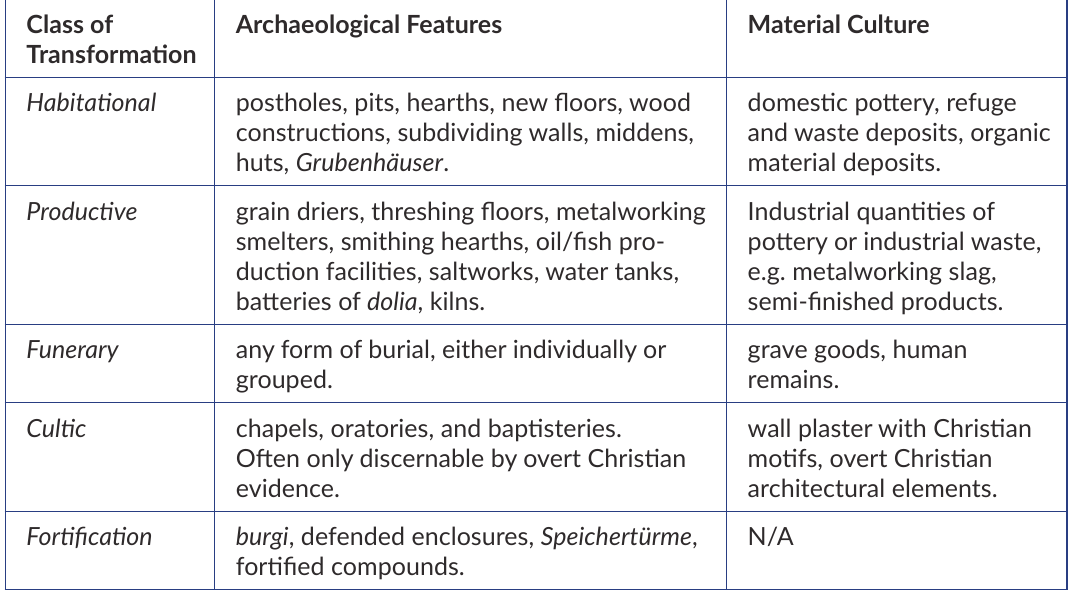
Table 1: A breakdown of the applied transformation classification system and associated feature types (after Dodd 2020: 36, Table